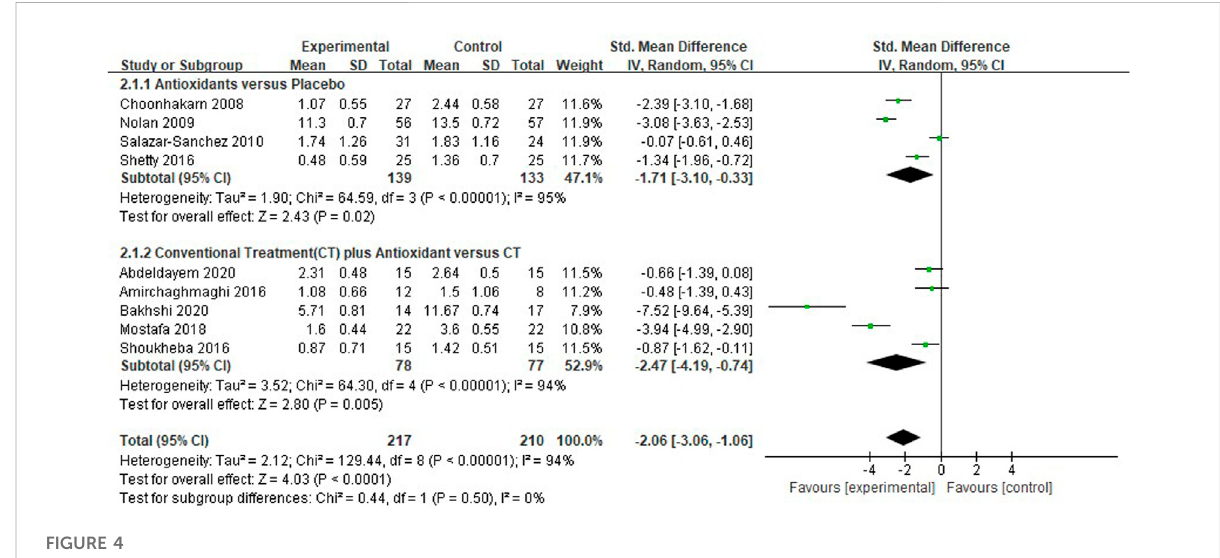
FIGURE 4 Forest plot of clinical